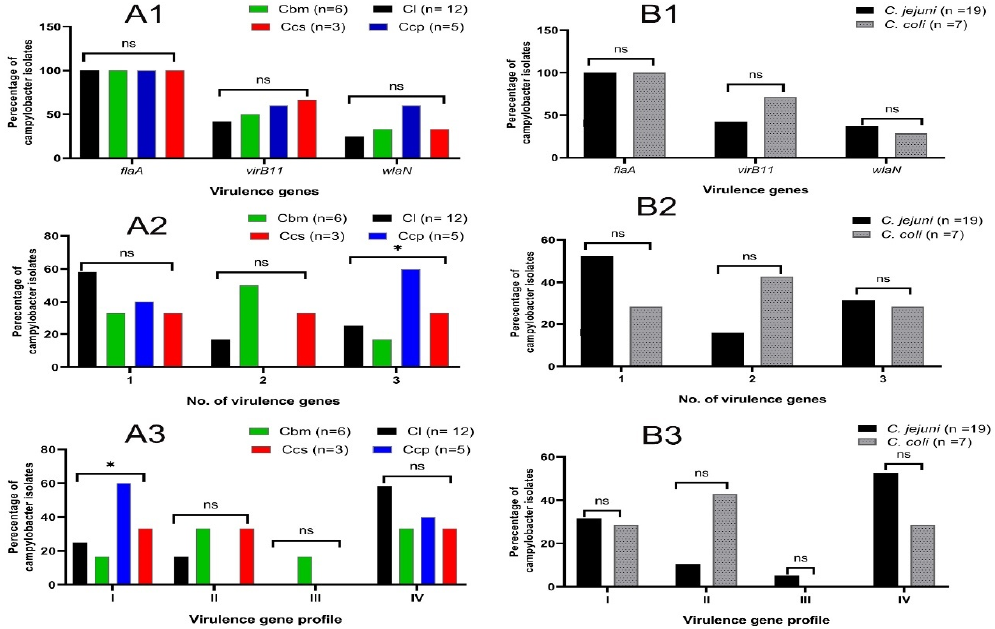
Figure 4. Distribution of the virulence genes among the total campylobacter isolates from the different chicken sources ( A1 – A3 ) and C. jejuni and C. coli ( B1 – B3 ). Cl: chicken liver; Cbm: chicken breast meats; Ccp: chicken cecal parts; Ccs: chicken cloacal swabs, n : number; ns: non-significant; * p